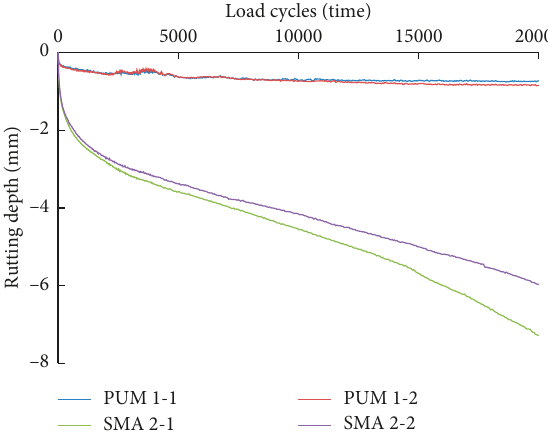
Figure 16: Rutting curves for the two mixtures. Table 5: Results of the Hamburg wheel tracking tests.